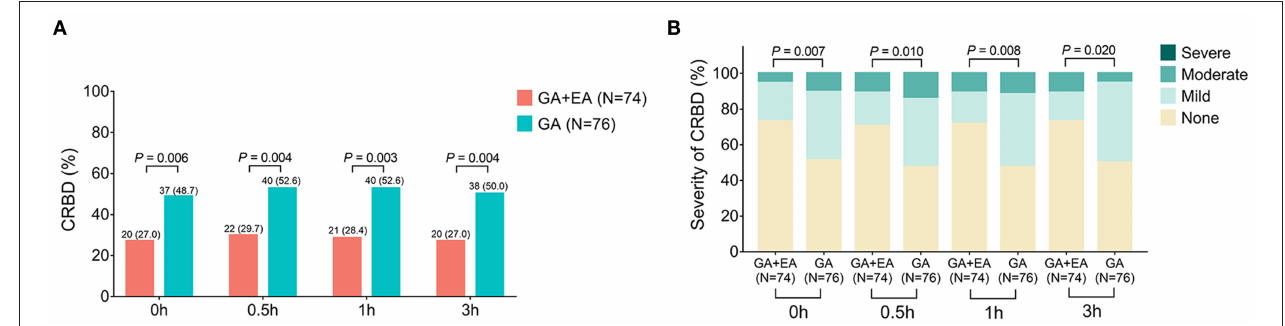
FIGURE 2 | Occurrence and severity of CRBD. Comparison of the occurrence (A) and severity (B) of CRBD between GA + EA group and GA group. CRBD, catheter-related bladder discomfort; GA, general anesthesia; EA, epidural anesthesia; h,